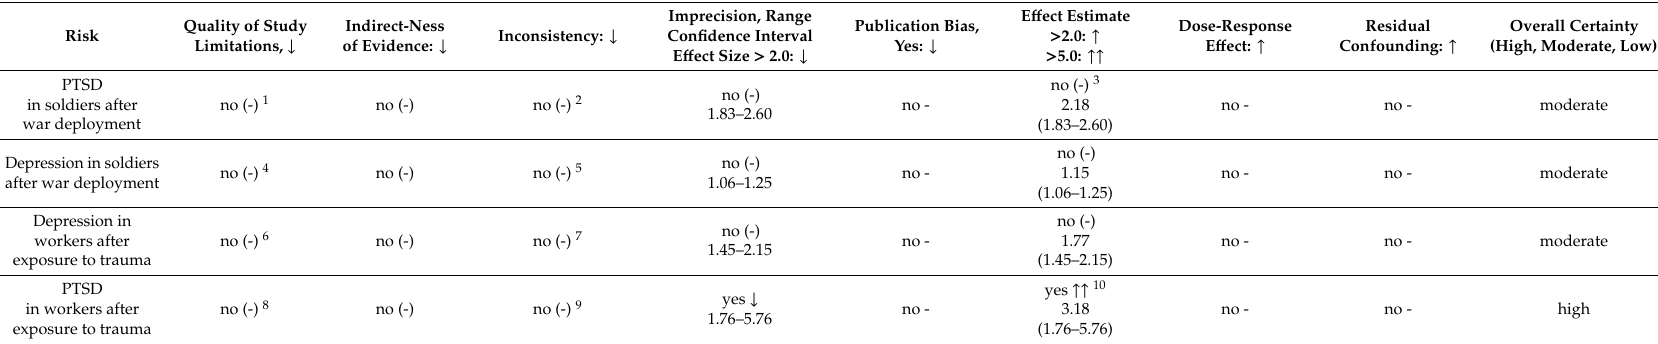
Table2. AssessmentofevidencefortheriskofstudiedoutcomesbasedonGradesofRecommendations, Assessment, Development,